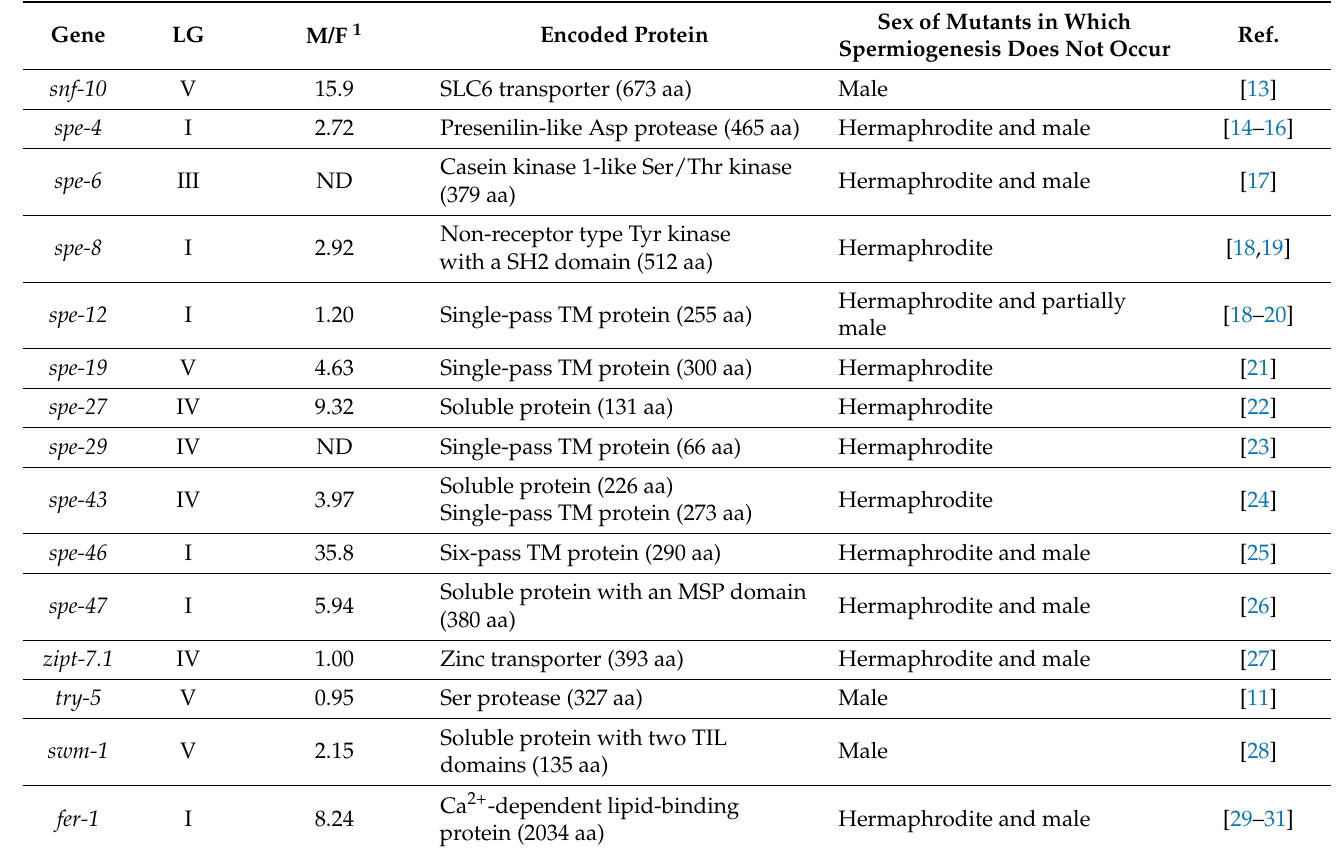
Table 1. Genes involved in C. elegans spermiogenesis